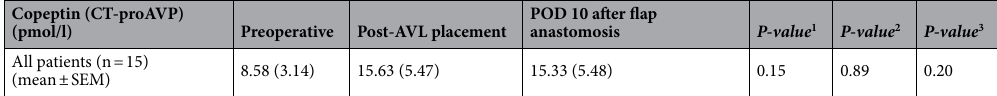
Table 4. Copeptin (CT-proAVP) levels of the patients. AVL = arteriovenous loop, POD = postoperative day. 1 T-Test Preoperative vs. Post-AVL placement. 2 T-Test Post AVL placement vs. POD 10 after flap anastomosis. 3 T-Test Preoperative vs. POD 10 after flap